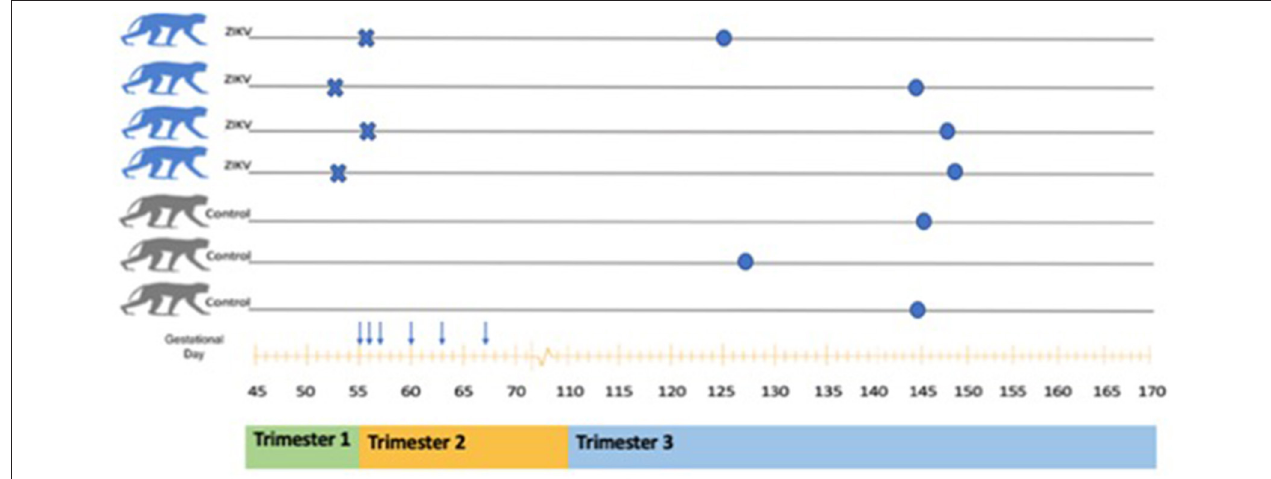
FIGURE 1 | Schematic of animals included in ZIKV analysis. A total of seven pregnant Rhesus Macaques were included (four ZIKV and three Controls). Inoculation with ZIKV PRVABC59 is indicated by the symbol X. Serial dam blood sampling is indicated by the symbol ↓ . Fetal delivery by cesarean is indicated by the symbol • . A rough correlation with human pregnancy trimesters is shown below the x axis (gestational age in days).